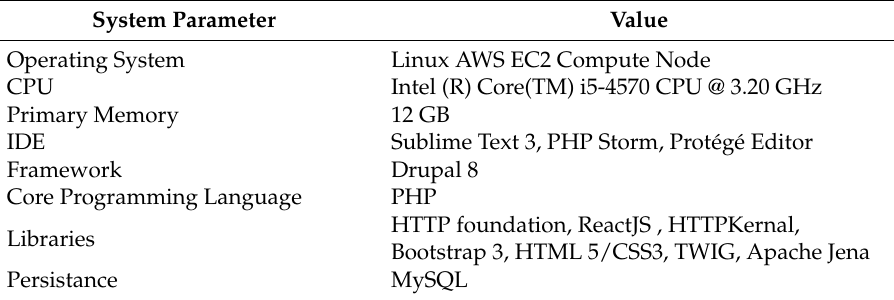
Table 4. Specification of implementation environment of application